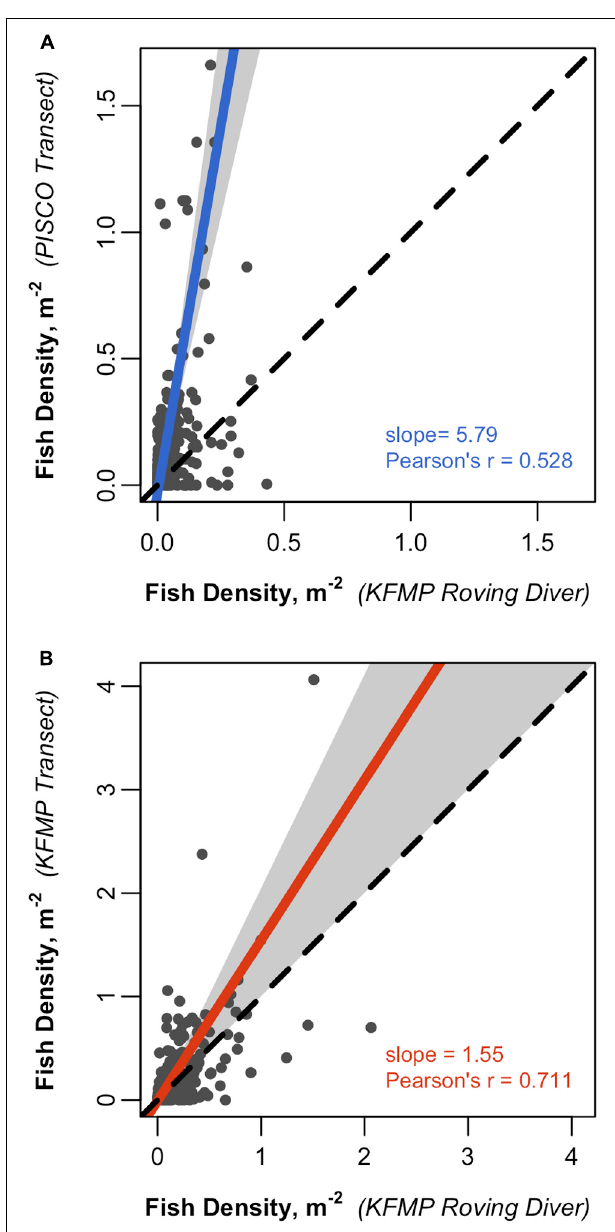
FIGURE 4 | Scatterplots comparing fish densities estimated from paired KFMP roving diver counts and (A) PISCO or (B) KFMP transects. The solid line represents a Deming linear regression and the dashed line represents the 1:1 line. The 0.95 confidence bounds are calculated with the bootstrap (quantile) method. Only taxa seen in 10 or more site pairs included: 27 taxa for (A) and 13 taxa for (B) .